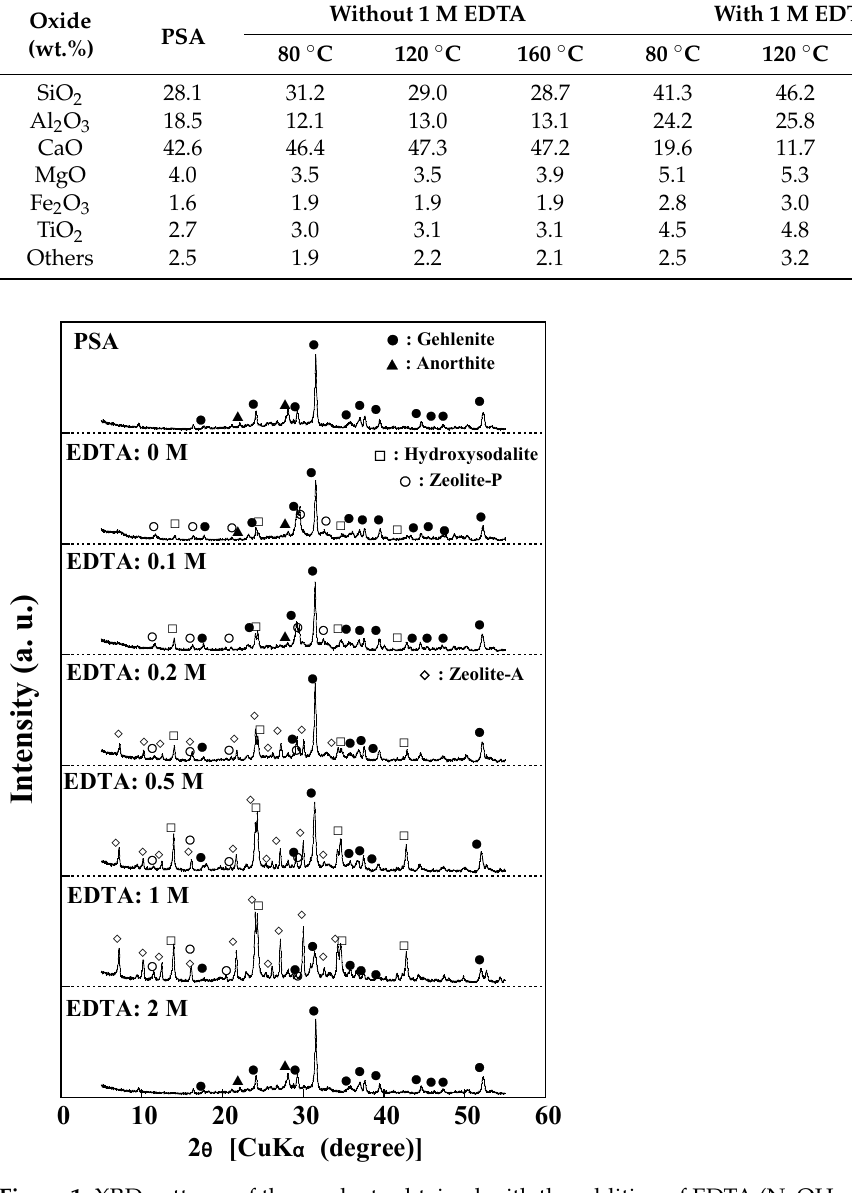
Figure 1. XRD patterns of the products obtained with the addition of EDTA (NaOH concentration: 3 M NaOH, Temperature: 80 °C, Reaction time: 24 h).